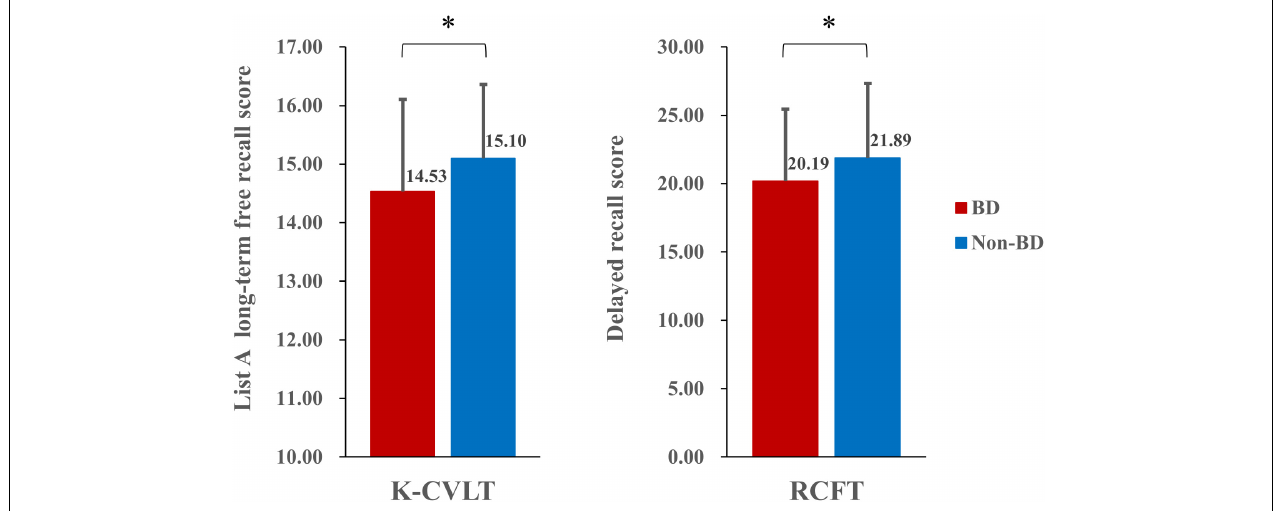
FIGURE 1 | Performance of the Korean version of the California Verbal Learning Test (K-CVLT) and Rey-Osterrieth Complex Figure Test (RCFT) in the binge and non-binge drinking groups. * p < 0.05.